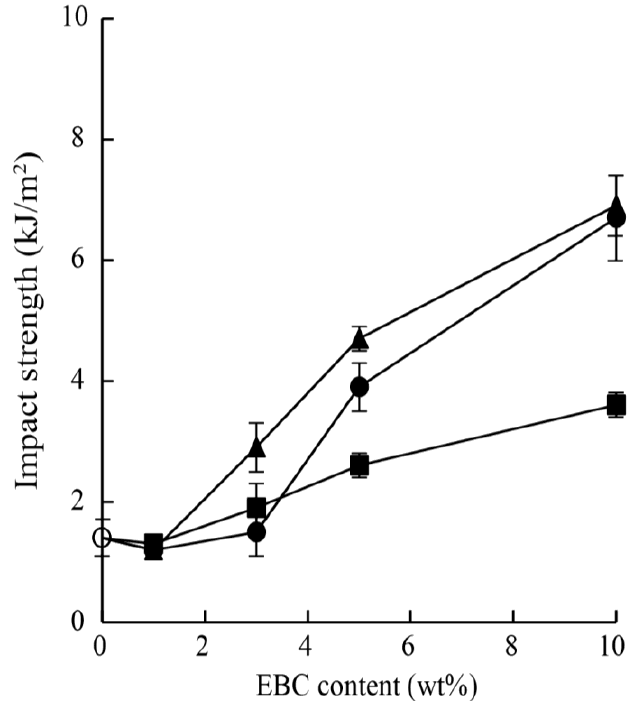
Figure 5. Izod impact strengths of neat PP (○), the PP/EBC blends (●) and the LCNF (▲) and wood flour (■) composites. The composites contained 1 wt% MAPP.